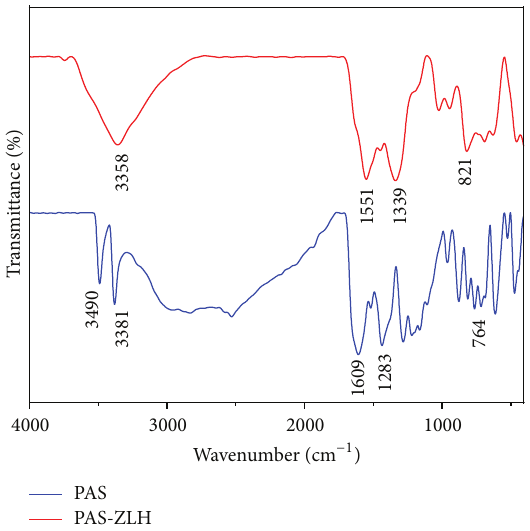
Figure 3: FTIR spectrum of PAS-ZLH (nanocomposite-A).